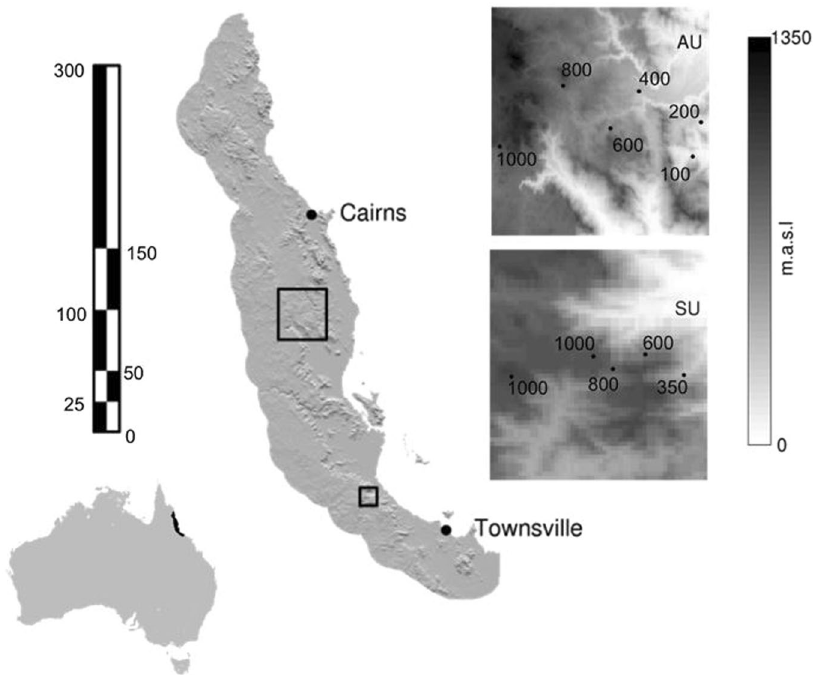
Figure 1. Map showing the Wet Tropics region and the location of the two transect areas (with left hand scale in Kms). The inset maps show the locations of the sample sites (with right hand scale showing shading to represent m.a.s.l.) on the Atherton transect (AU = Atherton Uplands) and the Paluma transect (SU = Spec Uplands after Mt Spec in Paluma). Figure created using the package SDMTools in R (GEODATA 9 S DEMVersion 2; © Commonwealth of Australia (Geoscience Australia) 2017, http://www.ga.gov.au/) 43,50